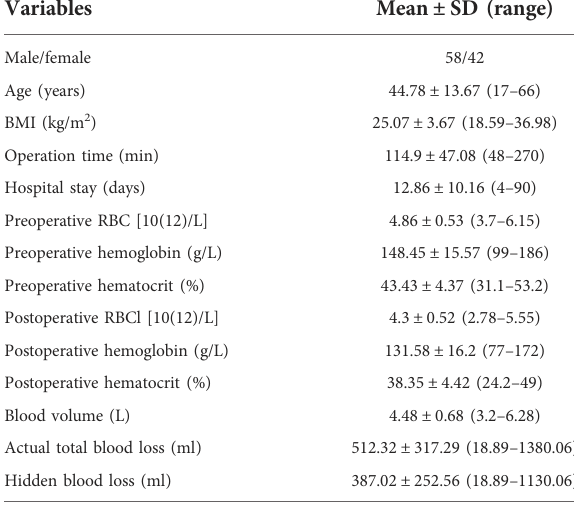
TABLE 1 Overall characteristics of the study population.